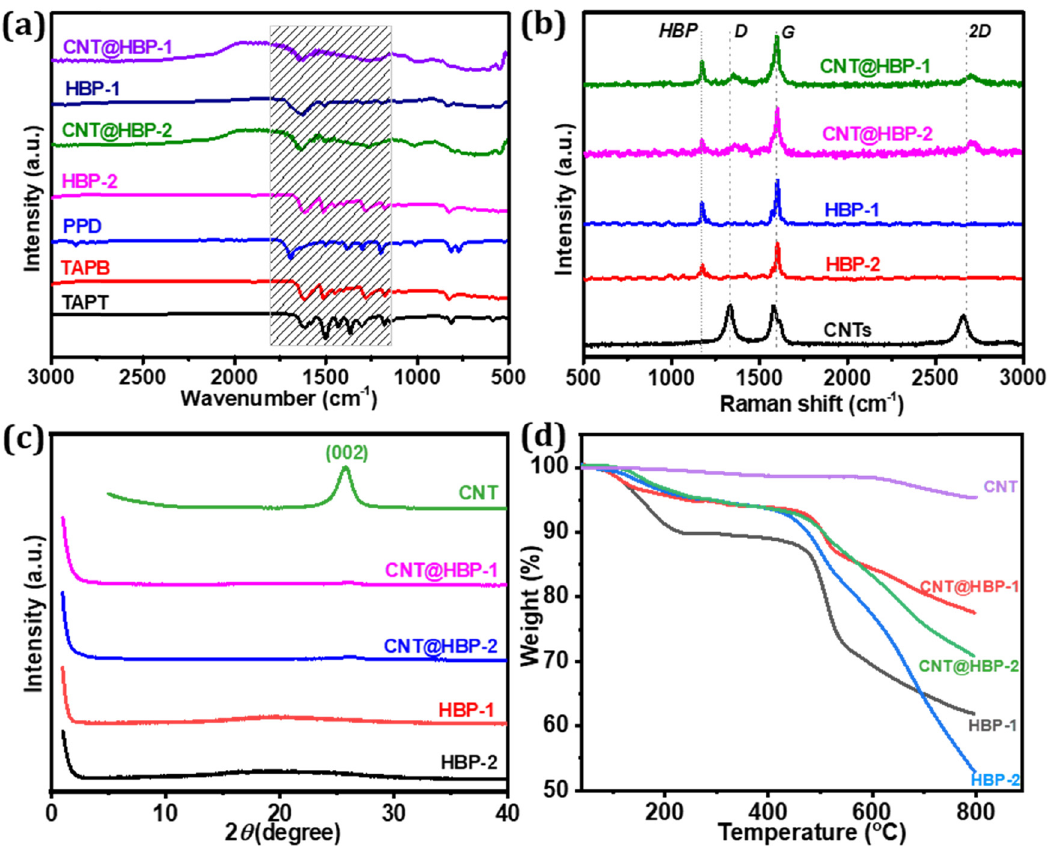
Figure 5: ( a ) FT - IR spectra, ( b ) Raman shifts, ( c ) XRD patterns, and ( d ) TGA curves of HBP - 1, HBP - 2, CNTs, CNT@HBP - 1, and CNT@HBP -